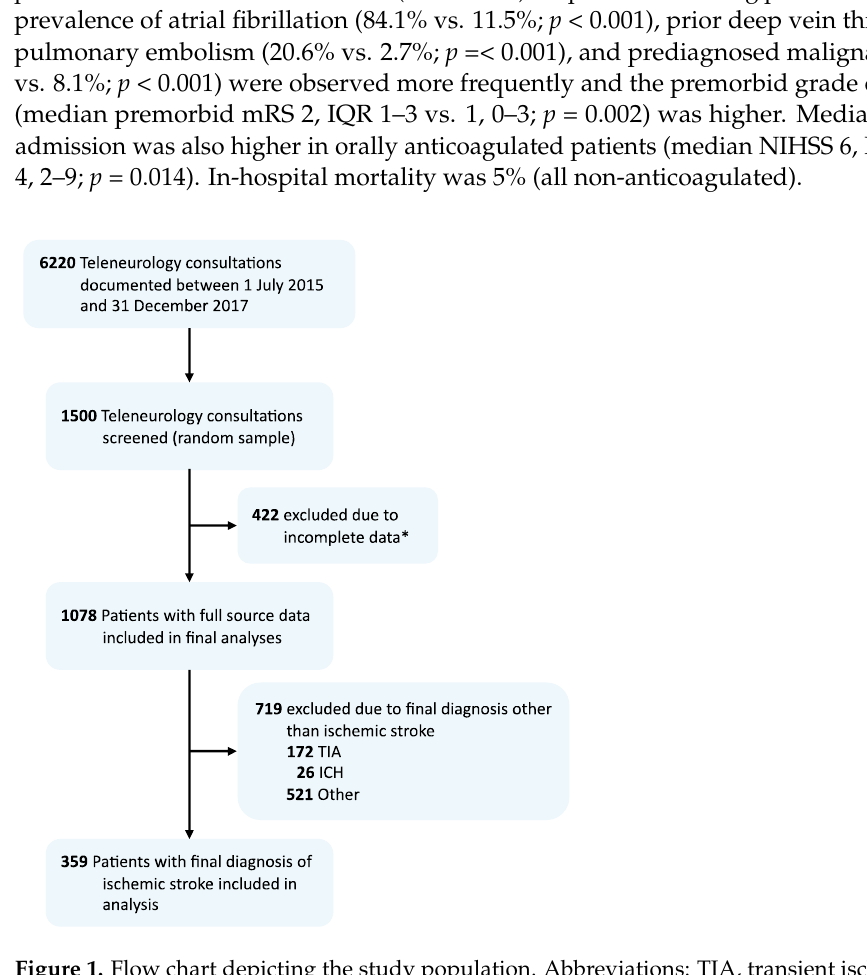
Figure 1. Flow chart depicting the study population. Abbreviations: TIA, transient ischemic attack; ICH, intracerebral hemorrhage. * Of 422 consultations excluded from analysis, n = 164 patients were excluded due to incomplete discharge data transfer to hub. In n = 228 patients, discharge data sets were incomplete or missing due to patients being transferred to third-party CSC, discharge against medical advice, errors linking archived documents to teleneurological consultations, or changes in hospital information system documentation standards (1 center). Another n = 30 consultations were ultimately canceled or performed with no written standardized documentations.